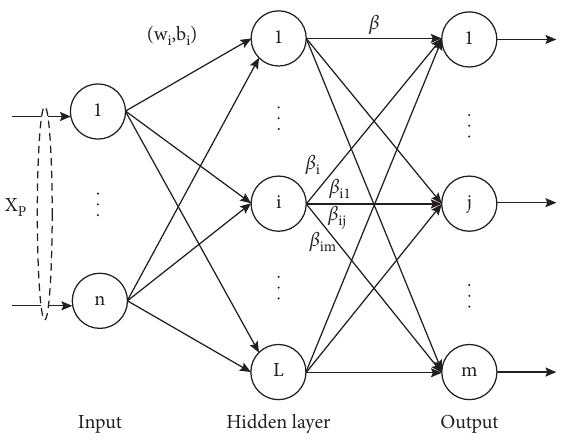
Figure 1: The structure of the ELM